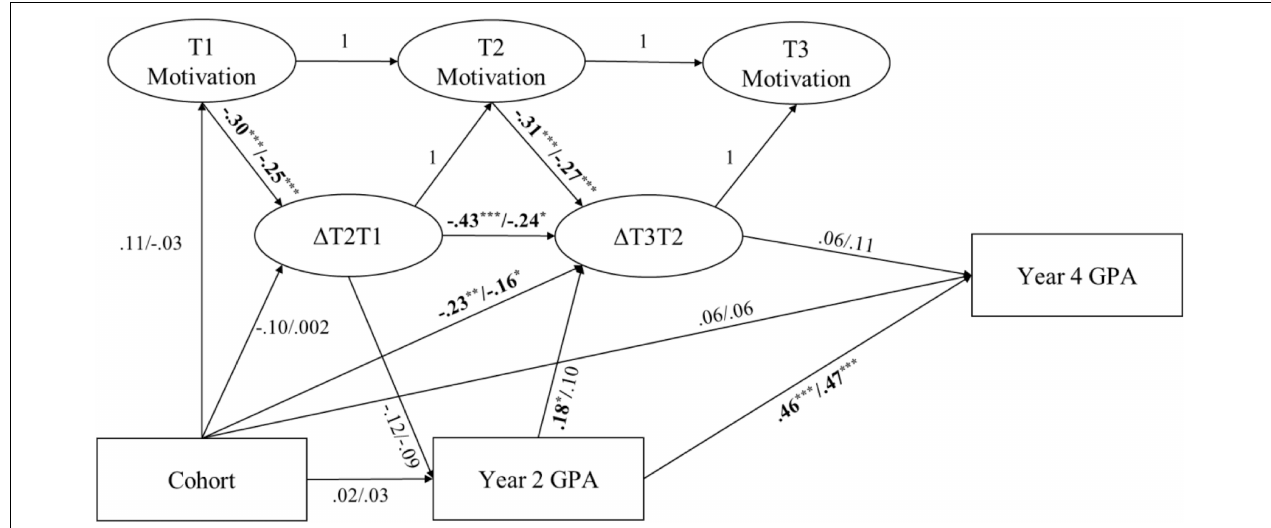
FIGURE 1 | Latent change model including initial levels of motivation, changes in motivation, and correlates of motivational changes. Models were conducted separately for each motivation type. Unstandardized coefficients are displayed for identified/intrinsic. ***p < 0.001, **p < 0.01, *p <